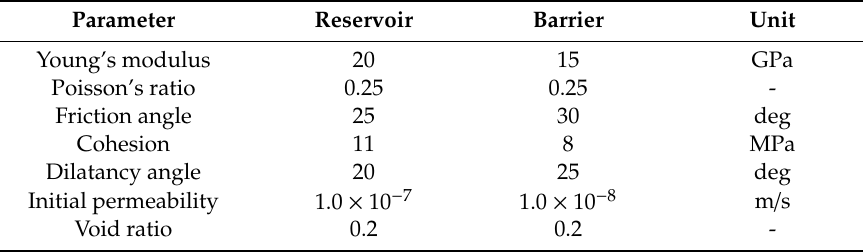
Table 1. Underlying parameters used in the numerical analysis. Parameter Reservoir